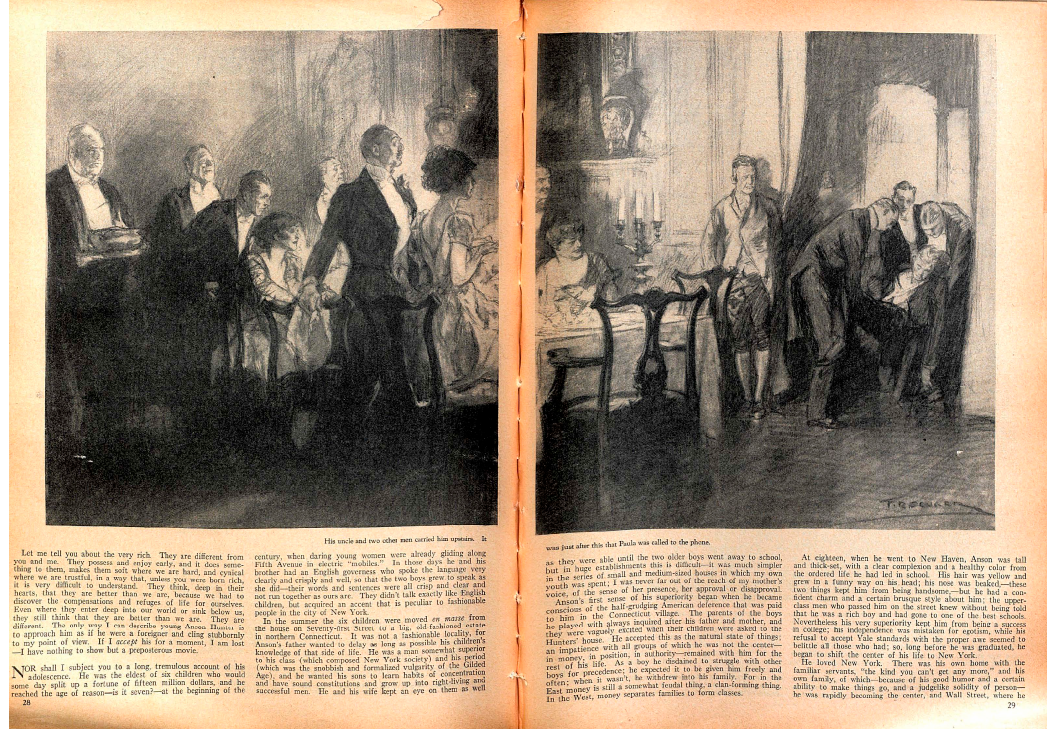
Figure 1. “The Rich Boy” as it first appeared in the January 1926 issue of Red Book Magazine (Fitzgerald 1926a), pp. 28–29.